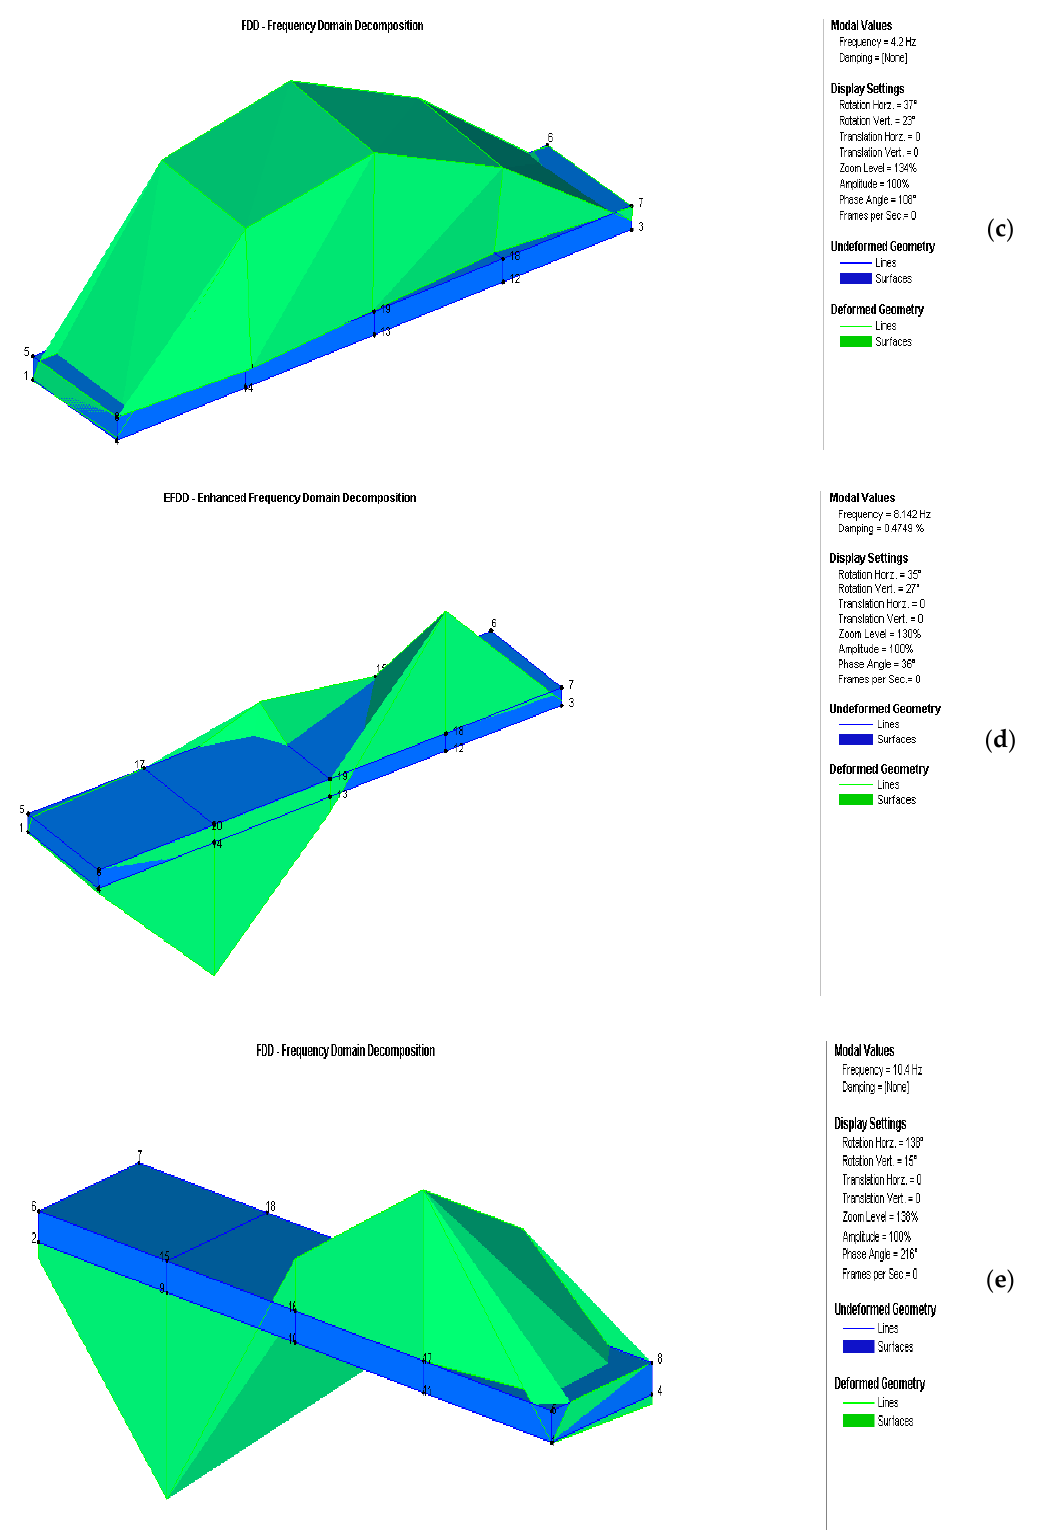
Figure 5. Shapes of modes received in the experimental modal analysis: ( a ) horizontal bending—half wave; ( b ) vertical rotation—half wave; ( c ) horizontal bending—half wave; ( d ) vertical rotation—2 half waves; ( e ) vertical bending—2 half waves.